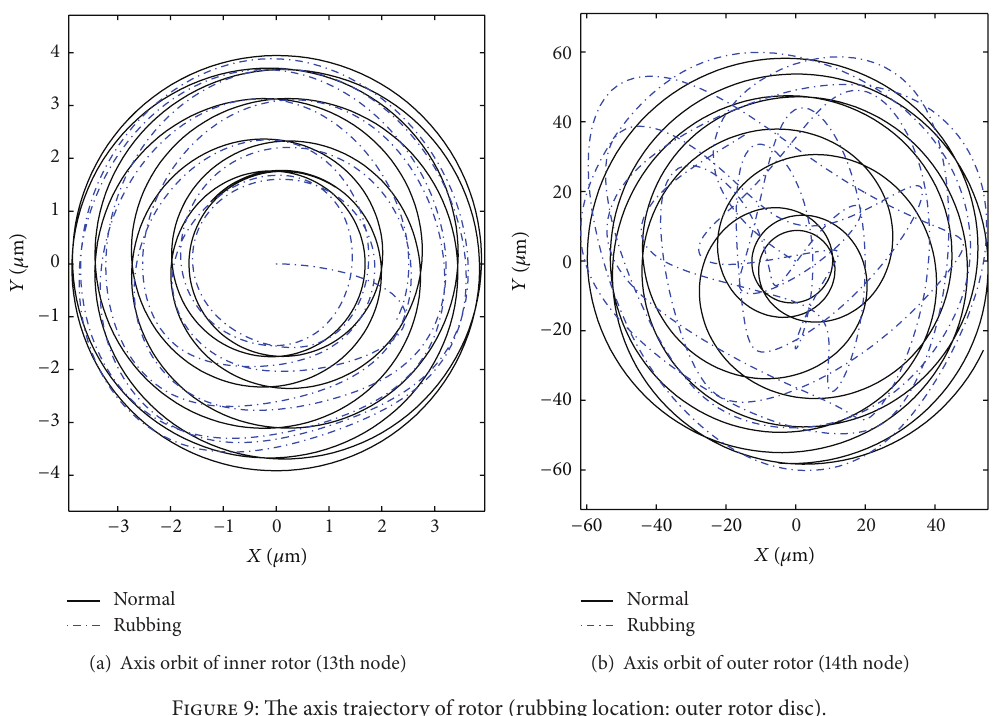
(b) Axis orbit of outer rotor (14th node) Figure 9: The axis trajectory of rotor (rubbing location: outer rotor disc).